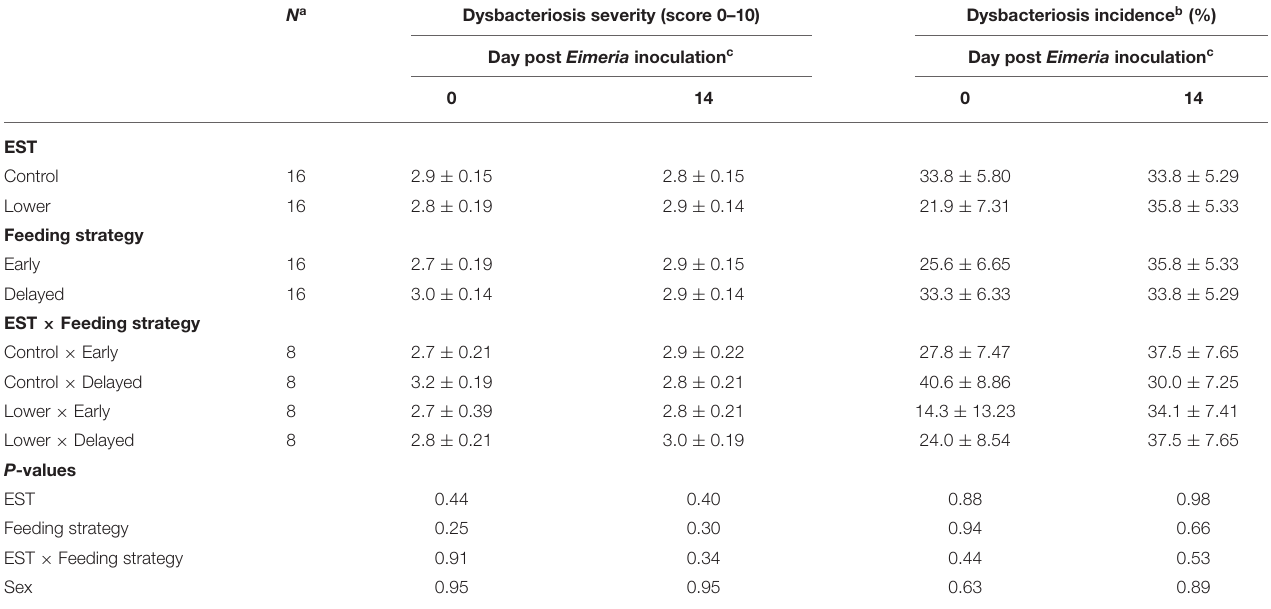
TABLE 4 | Effect of eggshell temperature ( EST ) during late incubation [ ≥ embryonic days 17–19.5; 37.8 ◦ C ( control ) or 36.7 ◦ C ( lower )] and/or feeding strategy after hatch [immediate access to feed and water ( early ) or 51–54-h deprivation ( delayed )] on dysbacteriosis of broilers at d 0 or 14 post Eimeria inoculation (d 21 post hatch) to induce necrotic enteritis (mean ± SE).